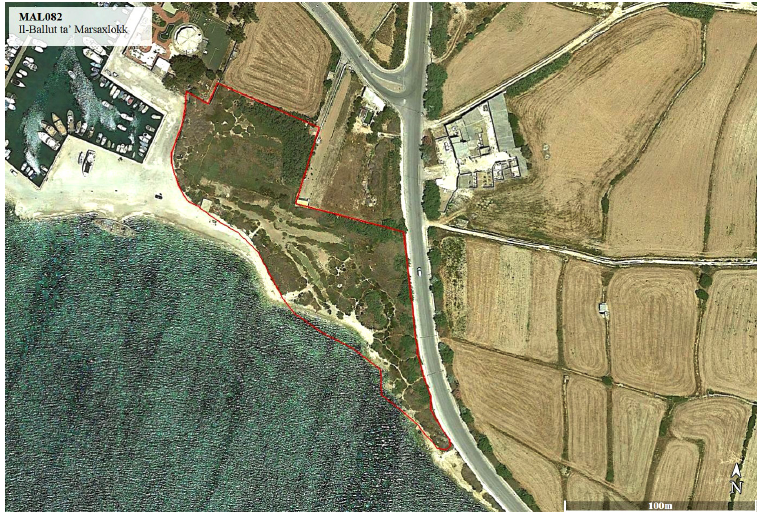
Figure 2. Il-Ballut ta’ Marsaxlokk Nature Reserve (MAL082) (source: Nature Trust – FEE Malta, 2020)